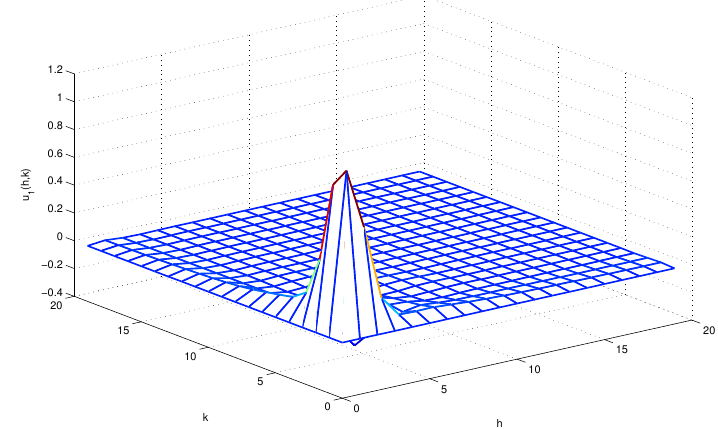
Figure 5. Sliding mode controller component: u 1